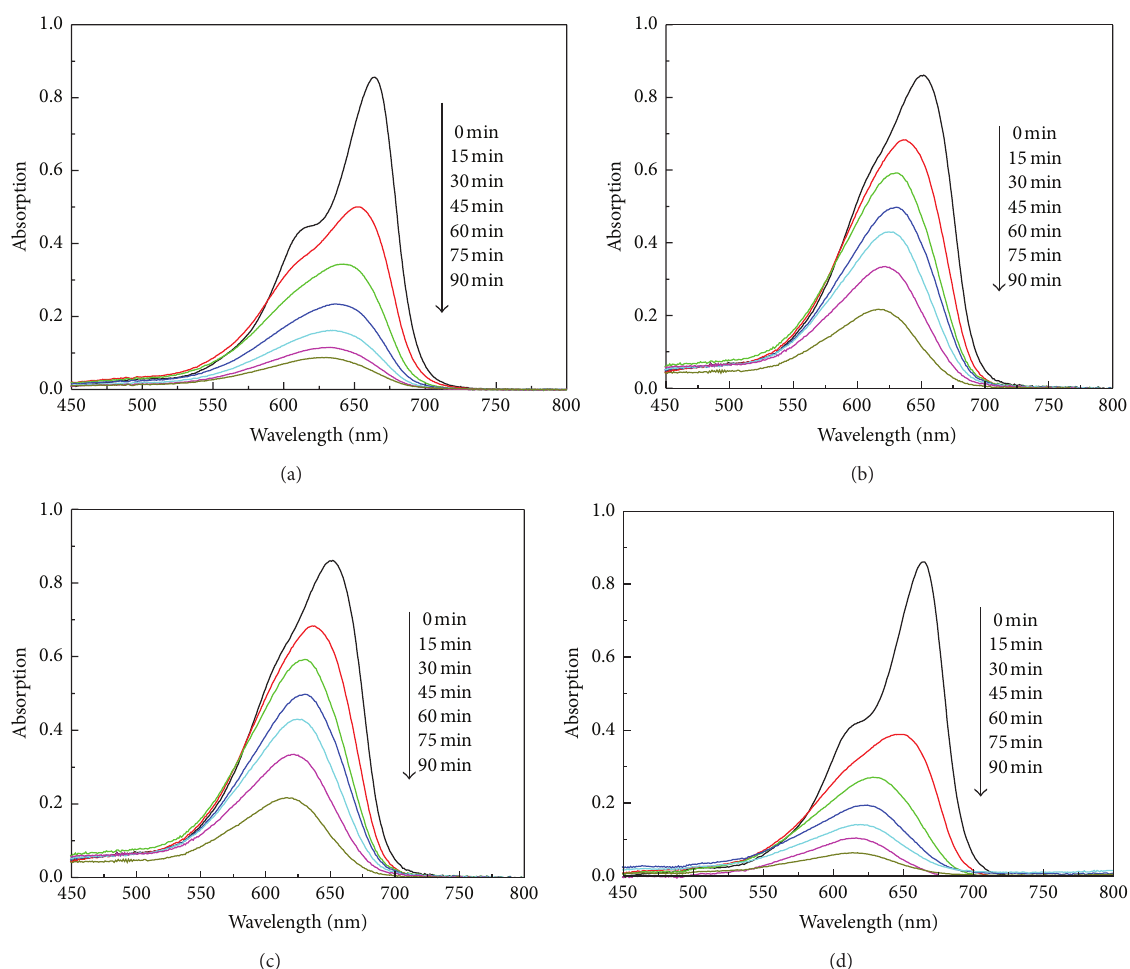
Figure 3: UV-vis absorption spectra of the MB solution in the presence of various photocatalysts under simulated sunlight irradiation: (a) S1, (b) S2, (c) S3, and (d) S4, respectively.